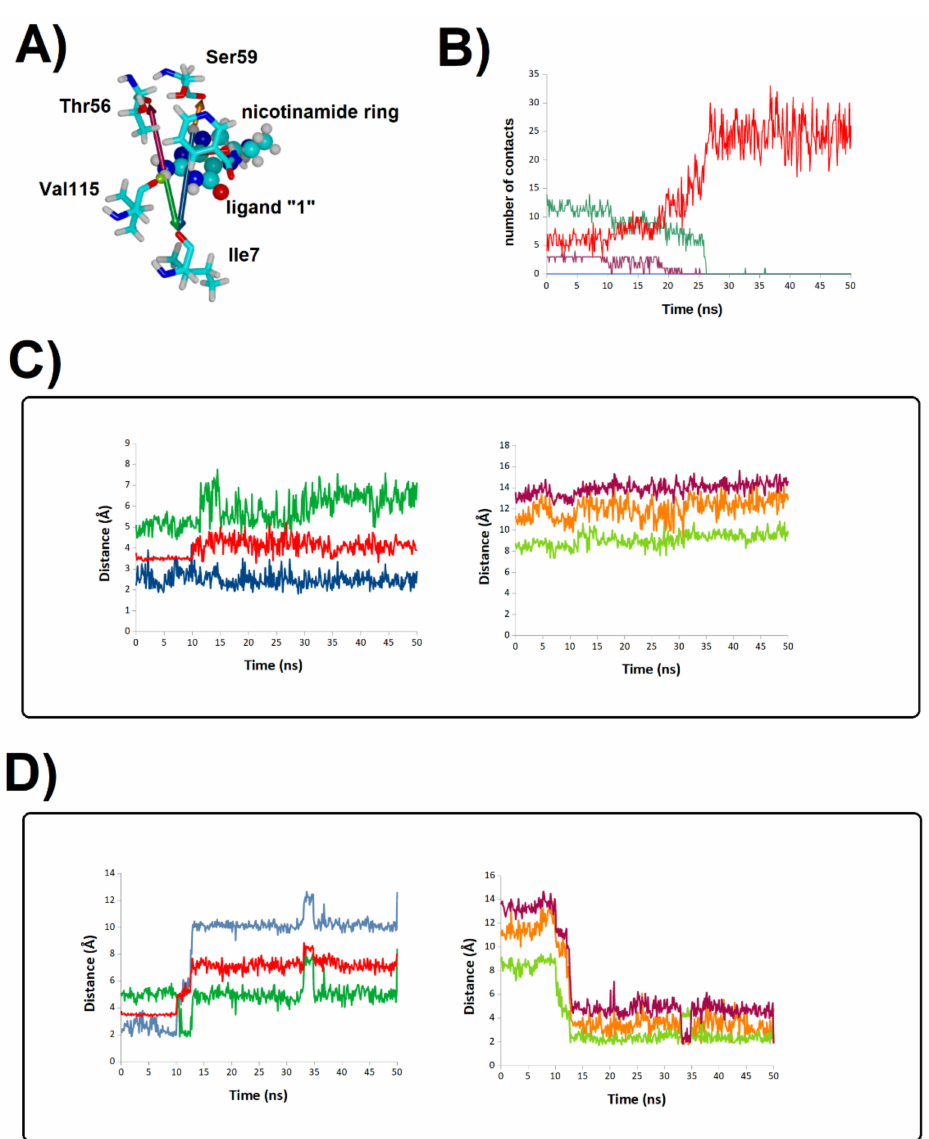
Figure 11. Stability of the binding mode of molecule 1 at the human DHFR active site. ( A ) Rep- resentative snapshot of a trajectory of pteridince core-bound human dihydrofolate-bound DHFR; ( B ) evolution of ligand-protein contacts in the simulation where unbinding was observed. Red: number water molecules < 3 Å from the ligand; green: number of amino acid residues < 3 Å from the ligand; violet: number of H-bonds between protein surface and the ligand; blue: number of H-bonds between NADPH and the ligand. ( C , D ) Evolution of key ligand-protein distances in the remaining two simulations. Each line in the graph corresponds to the evolution of the distance between the atoms connected with an arrow of the same color in panel ( A